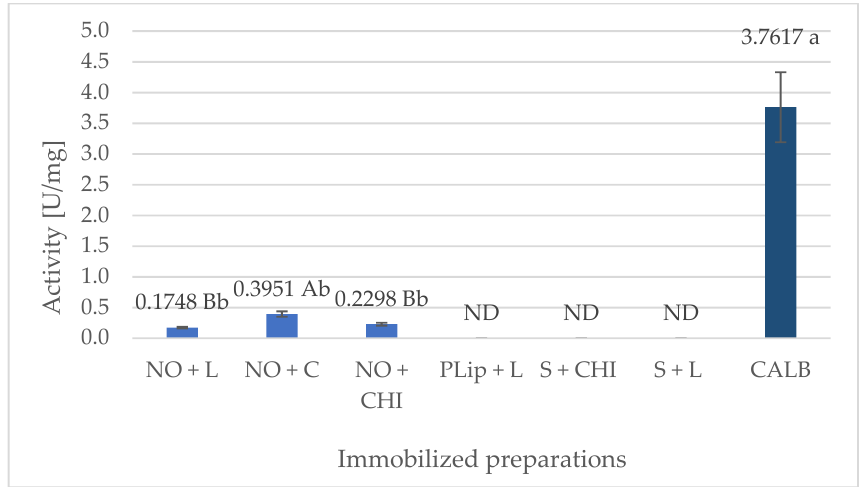
Figure 5. The synthetic activity of immobilized preparations: S + CHI: crude enzyme solution of Y. lipolytica immobilized chitosan powder; S + L: crude enzyme solution of Y. lipolytica immobilized on Lewatit VP OC 1600; PLip + L: purified lipase from Y. lipolytica immobilized on Lewatit VP OC 1600; NO + L: liquid lipase Novozym 51032 immobilized on Lewatit VP OC 1600; NO + C: liquid lipase Novozym 51032 immobilized on coffee grounds; NO + CHI: liquid lipase Novozym 51032 immobilized on chitosan powder; CALB: immobilized lipase B from C. antarctica as a reference; ND: not detected. Means with the same capital letter A or B in the case of liquid lipase Novozym 51032 immobilized on different supports (and a or b in the case of all biocatalysts) did not differ significantly ( α =